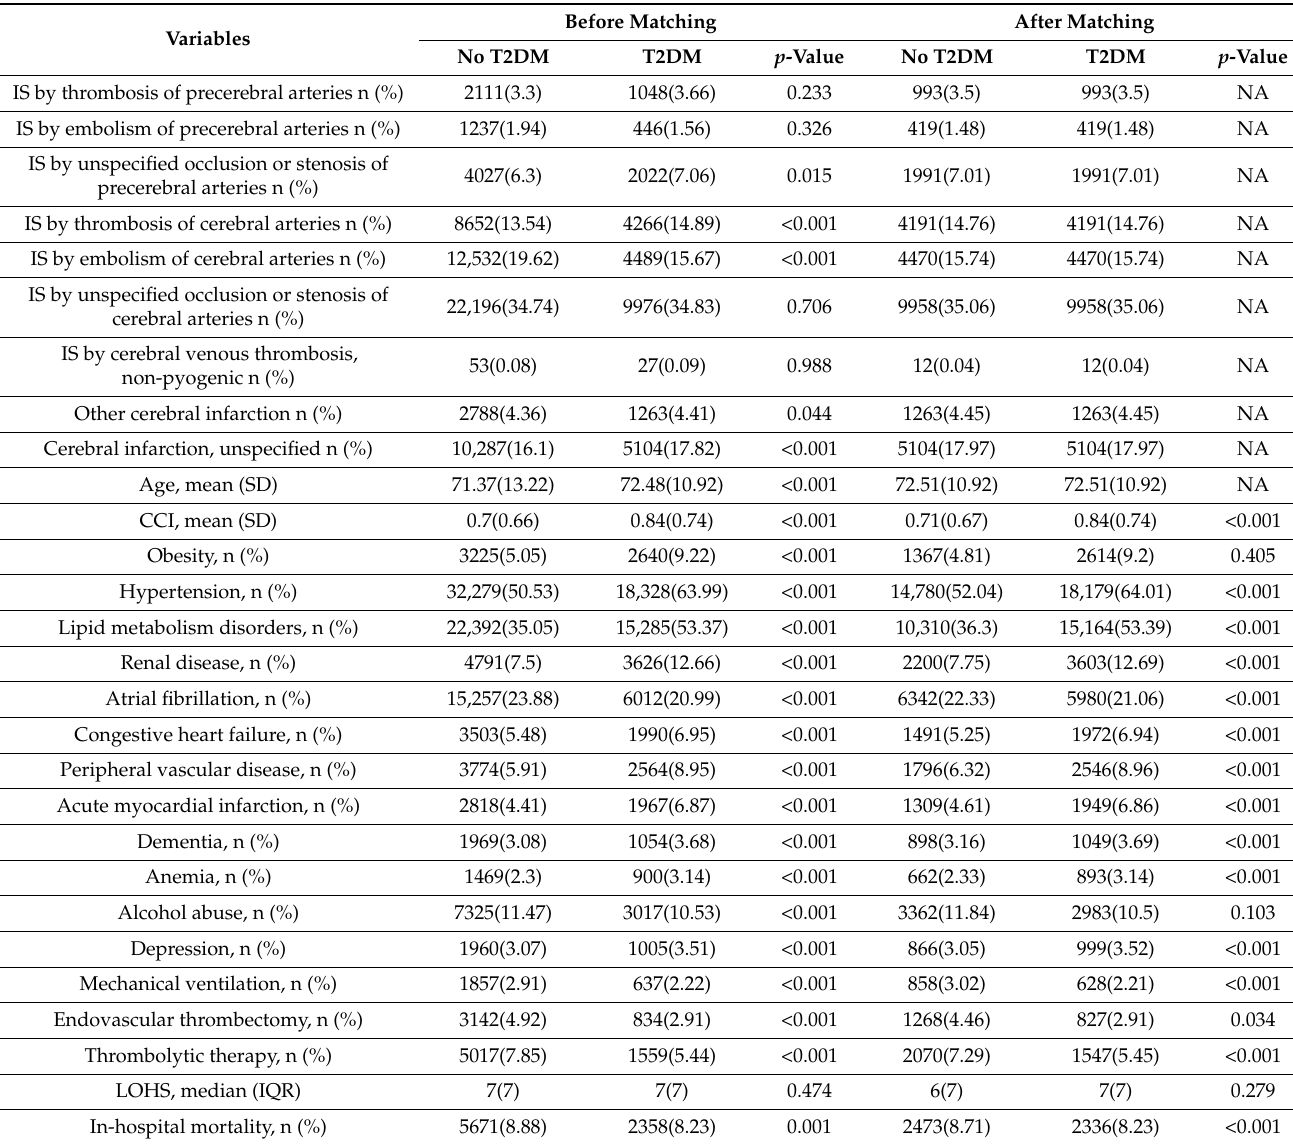
Table 2. Clinical characteristics, use of therapeutic procedures, and hospital outcomes before and after matching by age and ischemic stroke type (ICD 10) for men patients with ischemic